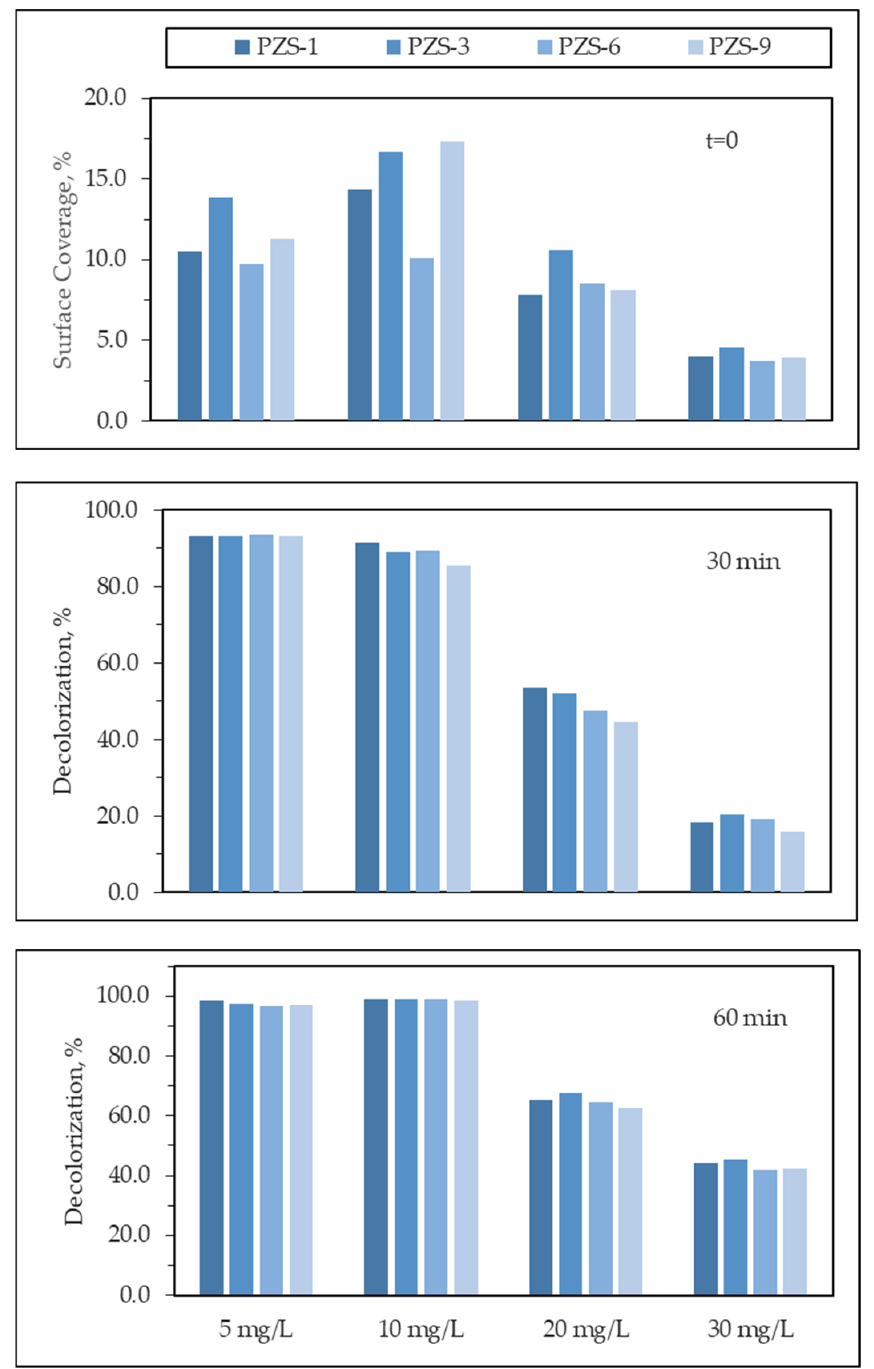
Figure 16. Photocatalytic degradation of MB upon use of PZS specimens: Initial MB concentration effect.